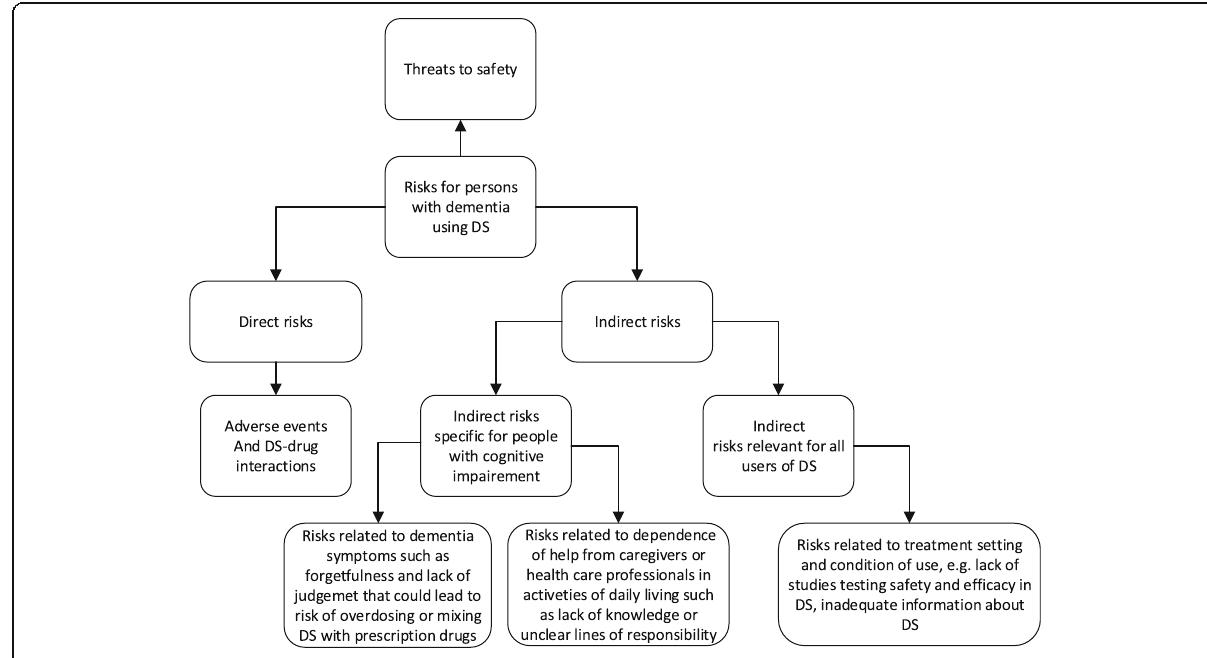
Fig. 1 Risks related to use of dietary supplements in persons with dementia. Abbreviation : DS , dietary